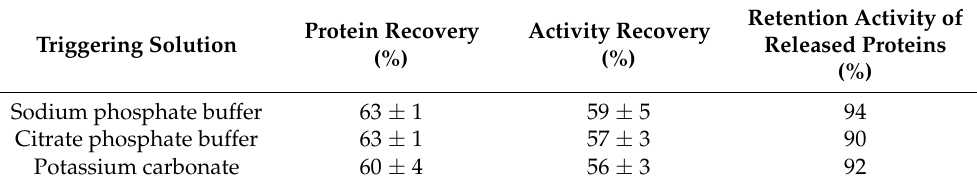
Table 5. Protein and activity recovery of cutinase from LDH/Cut-2/1 after 4 h release in different solutions; the retained activity is calculated with respect to the protein